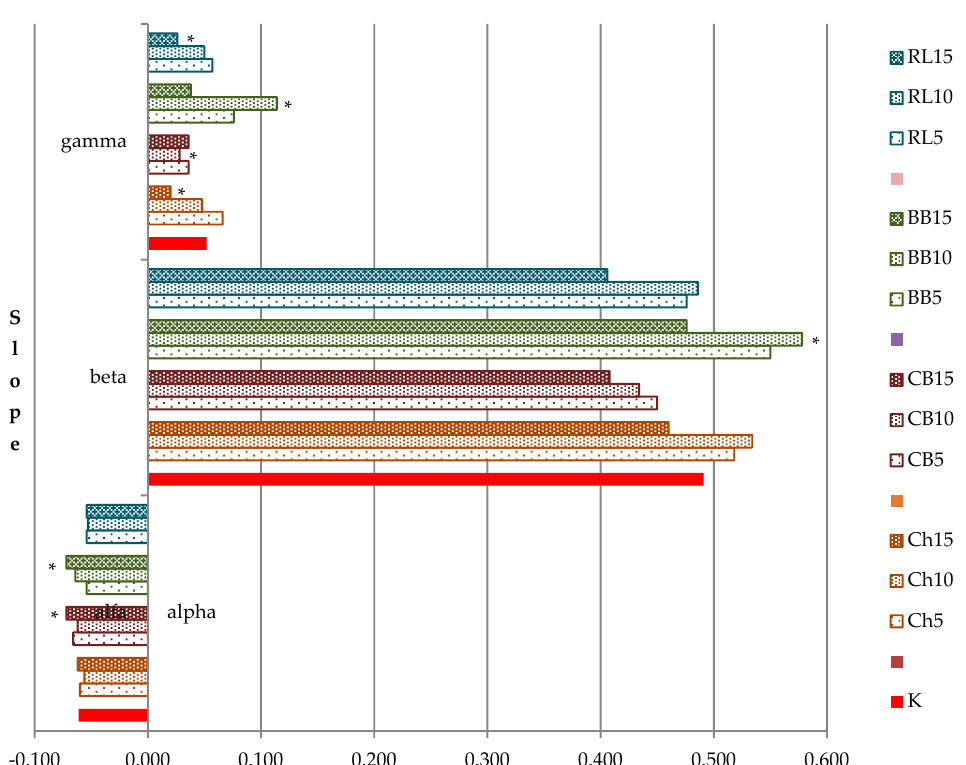
Figure 4. Mixolab calculated parameters alpha, beta and gamma slopes. * values are significantly different ( p < 0.05) compared to control. K + WF(50) + RF(50); Ch5 + WF(50) + RF(45) + ChF(5); Ch10 + WF(50) + RF(40) + ChF(10); Ch15 + WF(50) + RF(35) + ChF(15); CB5 + WF(50) + RF(45) + CBF(5); CB10 + WF(50) + RF(40) + CBF(10); CB15 + WF(50) + RF(35)